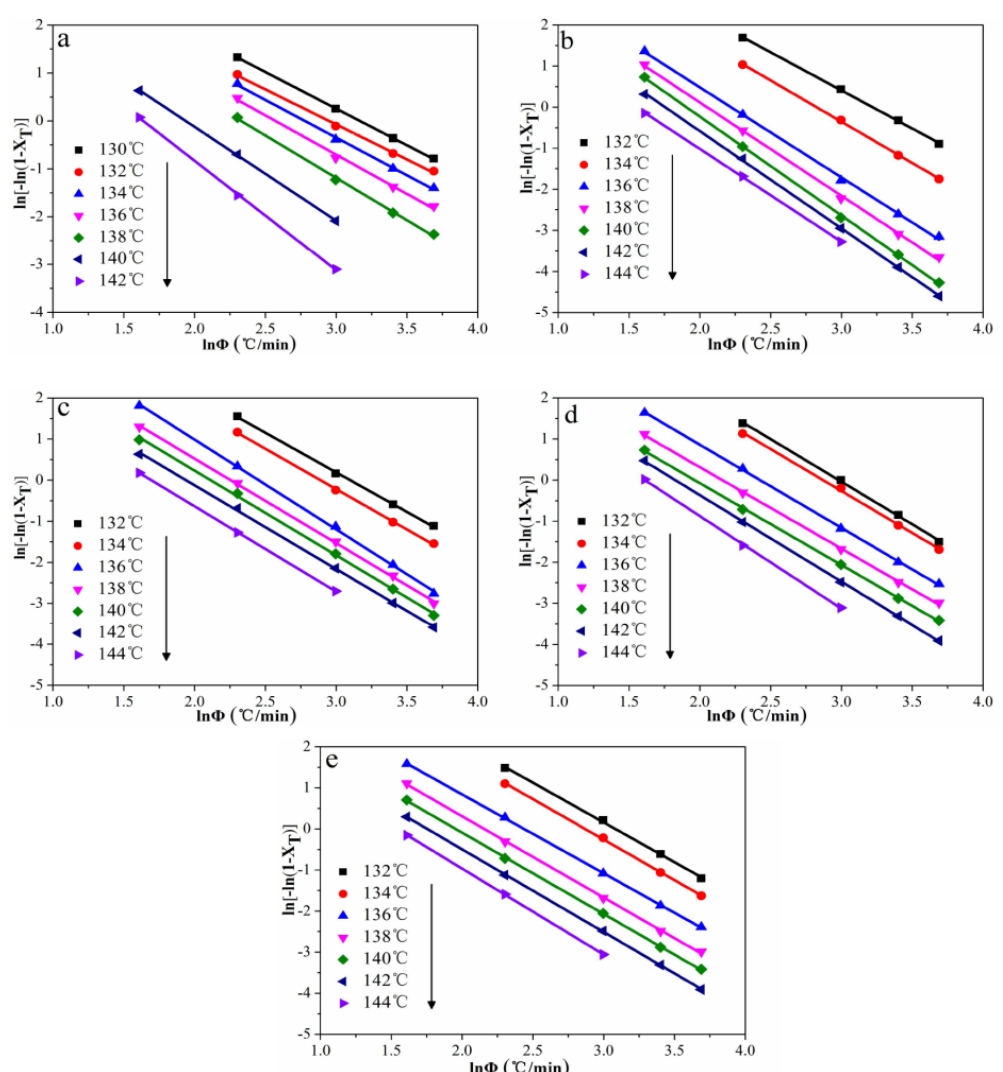
Figure 10. Plots of ln( − ln(1 − X T )) as a function of ln Φ for POM/Ag nanocomposites with different Ag nanoparticle contents: ( a ) 0, ( b ) 0.1, ( c ) 0.5, ( d ) 1, ( e ) 2 wt % at different fixed temperature . Table 3. Parameters of Ozawa analysis for the POM/Ag nanocomposites.